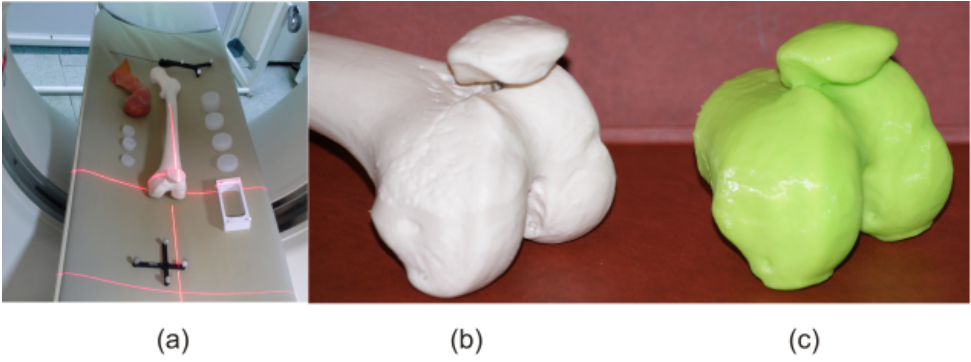
Figure 11. Artificial femur: ( a ) CT study, ( b ) femoral head, and ( c ) 3D model of femoral